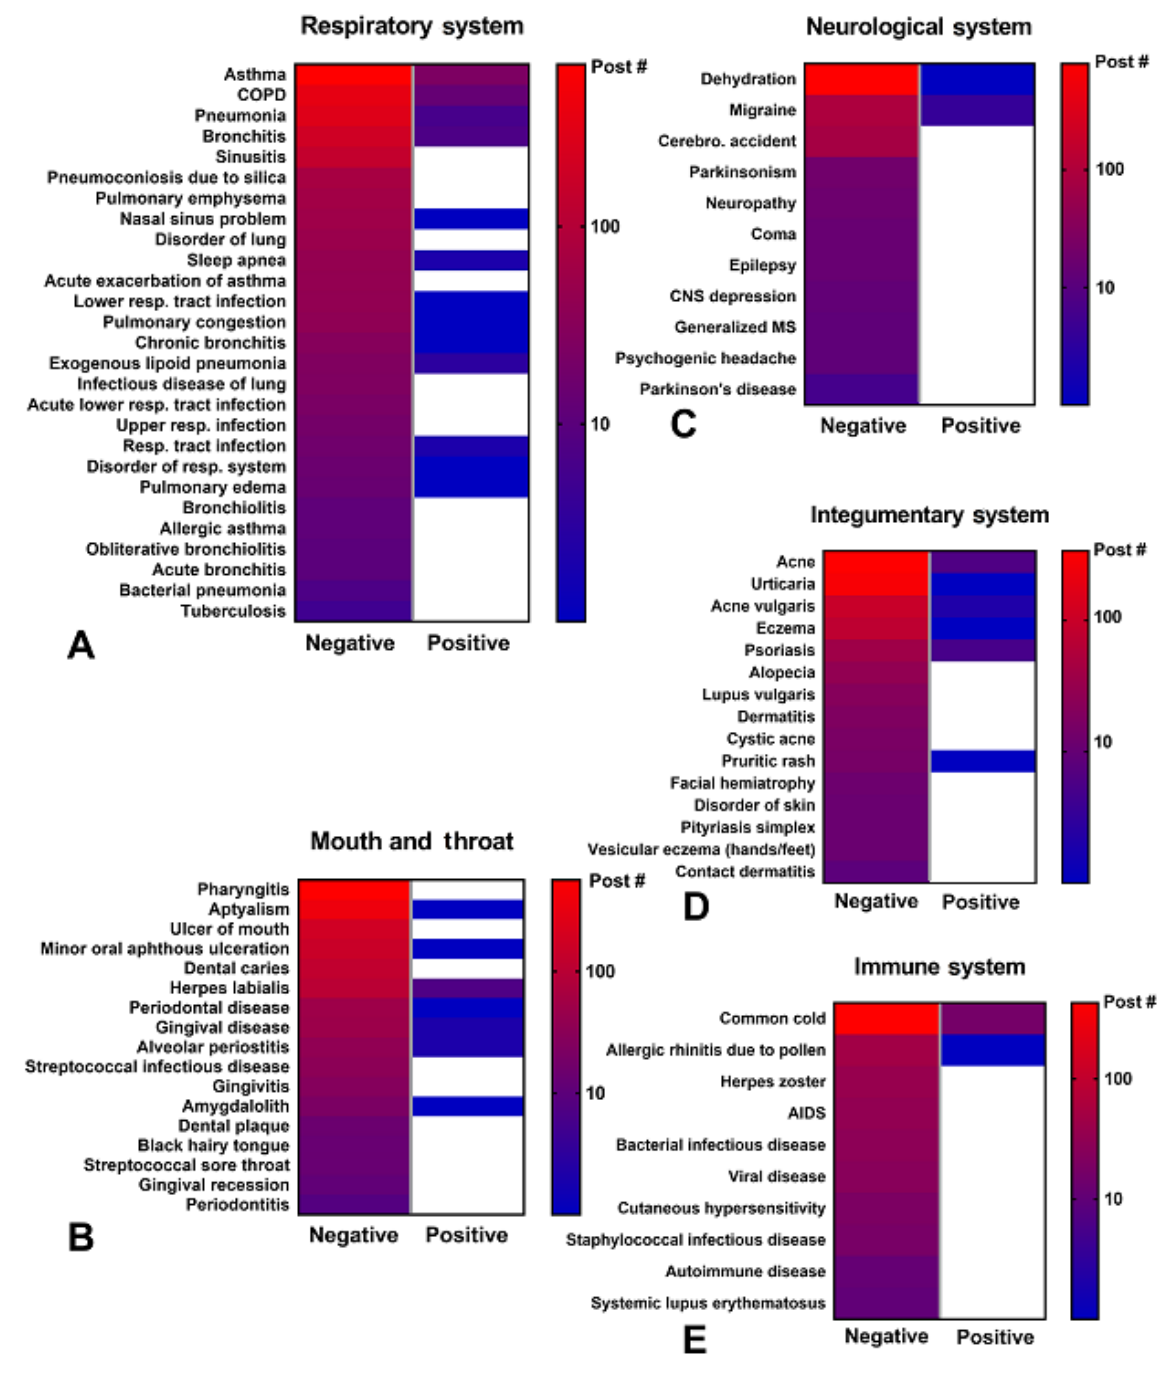
Figure 5. Heat map of specific disorders reported in the respiratory, mouth and throat, neurological, integumentary, and immune systems. The total number of posts for each disorder is shown on a log scale ranging from high (red) to low